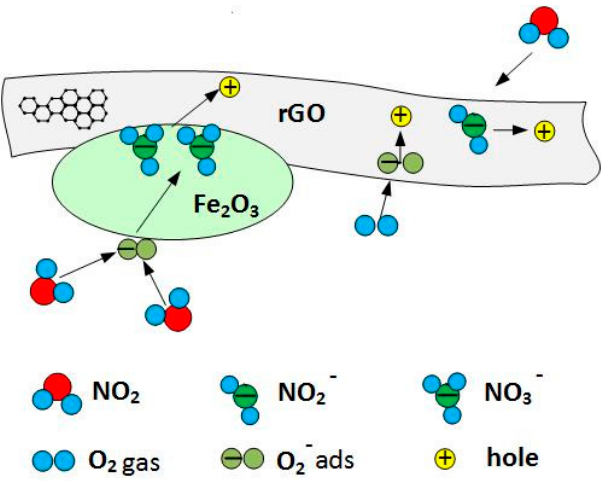
Figure 9. Interaction of NO 2 gas with oxygen adsorbed on Fe 2 O 3 surface can effectively increase the concentration of holes in rGO.